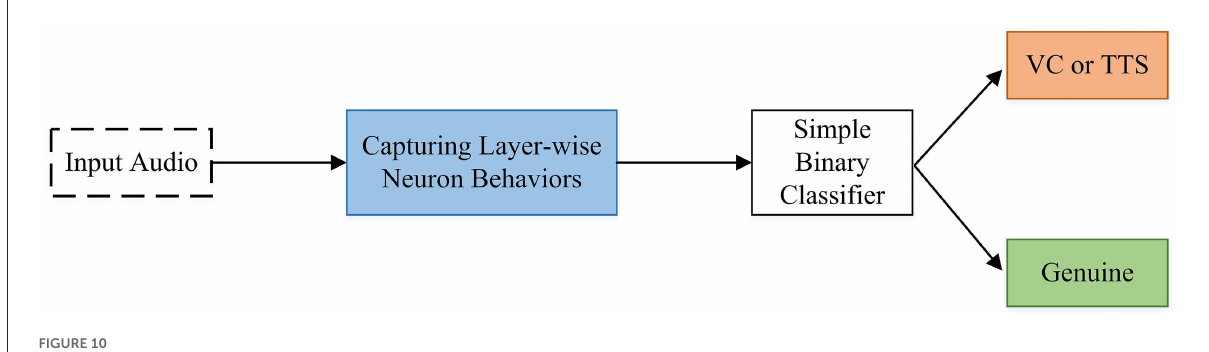
FIGURE10 DeepSonar architecture for detecting AI-synthesized fake